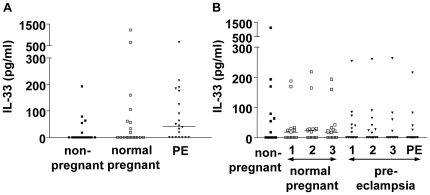
Circulating IL-33 in pregnancy and pre-eclampsia.A) IL-33 was detected by ELISA in the serum from women with a diagnosis of pre-eclampsia, matched controls who had a normal pregnancy and matched non-pregnant women (n = 20). No significant differences in IL-33 were identified. Bars represent median values. B) IL-33 was detected by ELISA in samples taken throughout pregnancy in women who developed pre-eclampsia and matched controls who had an uncomplicated pregnancy (n = 15). Blood samples were taken in each trimester of pregnancy (1, 2, 3) and at the diagnosis of pre-eclampsia (PE), and compared to non-pregnant matched women. There were no significant differences throughout pregnancy or between normal and pre-eclampsia pregnancies. Bars represent median values.